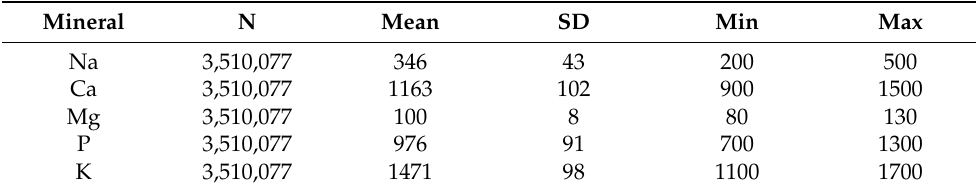
Table 5. Descriptive statistics of large-scale phenotyping on the mid-infrared predictions Walloon database. The means, standard deviation, and minimum and maximum values are expressed in